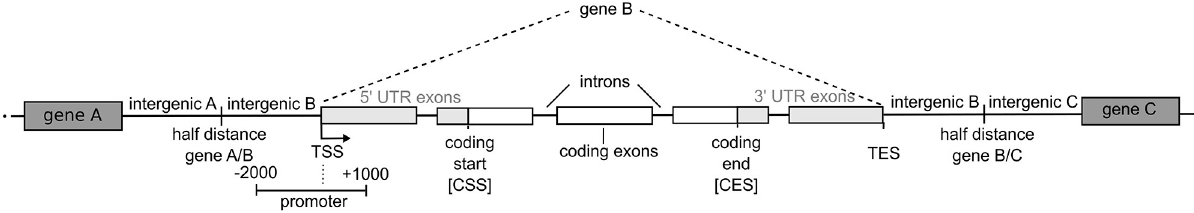
Fig 1. Definition of human genomic regions. Definition of the basic genomic regions: intergenic region, promoter region, 5’ UTR, coding exon(s), 3’ UTR, all exons, intron(s), intragenic region and CpG islands (not shown here). Shown is the + strand, − strand is analogous.